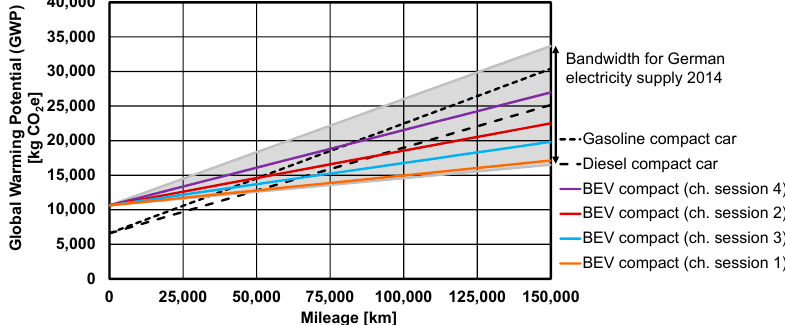
Figure 6. GWP over the life cycle of a compact class BEV in comparison to gasoline and diesel cars, using different GWP values of the public electricity supply of Germany in 2014.